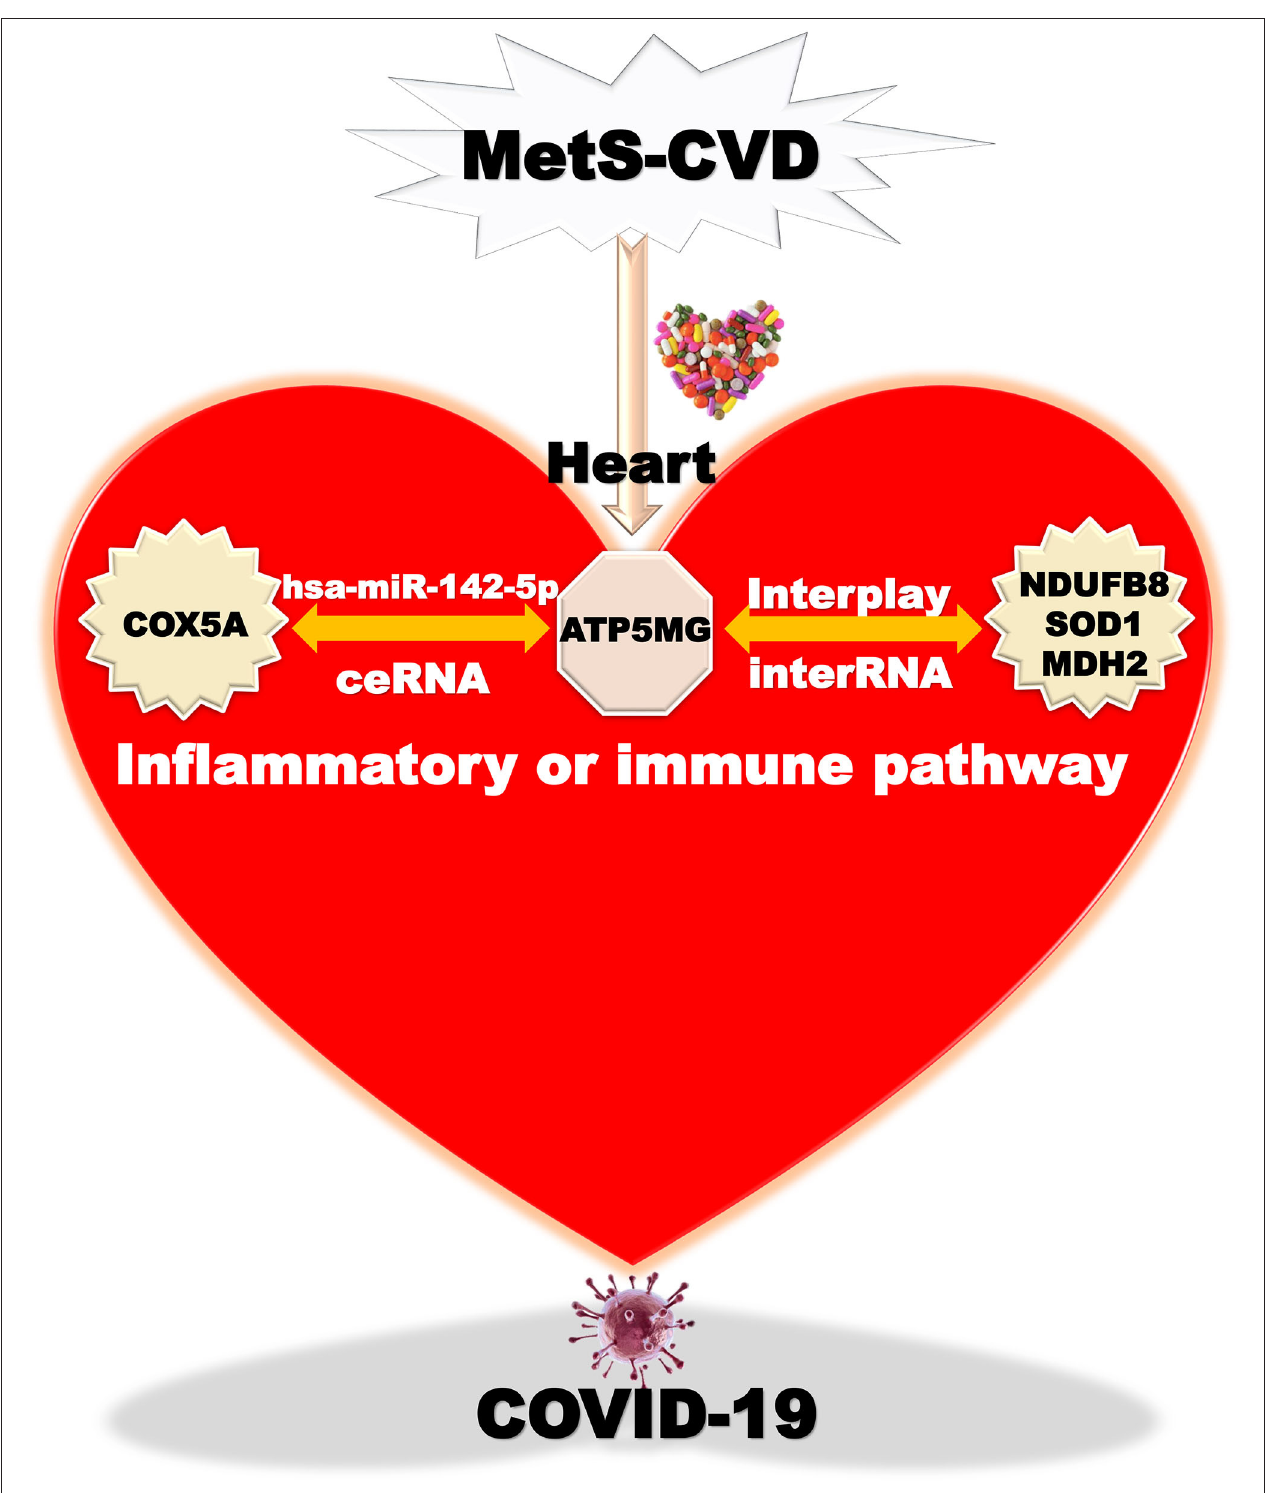
FIGURE 8 | Taking home message on ATP5MG-centered network. Inflammatory or immune pathway mediated by ATP5MG-centered network in MetS-CVD. Chemicals or drugs target this network formed by the ceRNA subnetwork and interRNA subnetwork. This network may be involved in COVID-19.